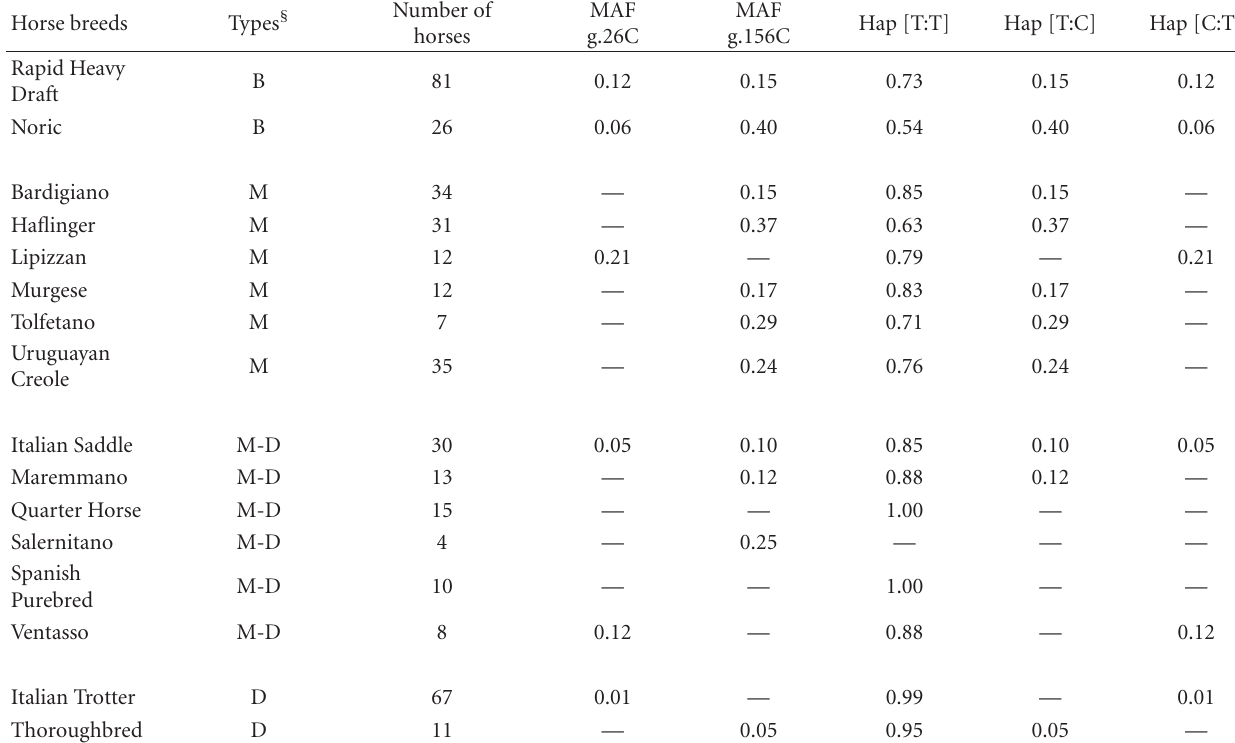
Table 3: Minor allele frequency (MAF) and haplotype (Hap ∗ ) frequencies of the two promoter SNPs of the MSTN gene in di ff erent horse